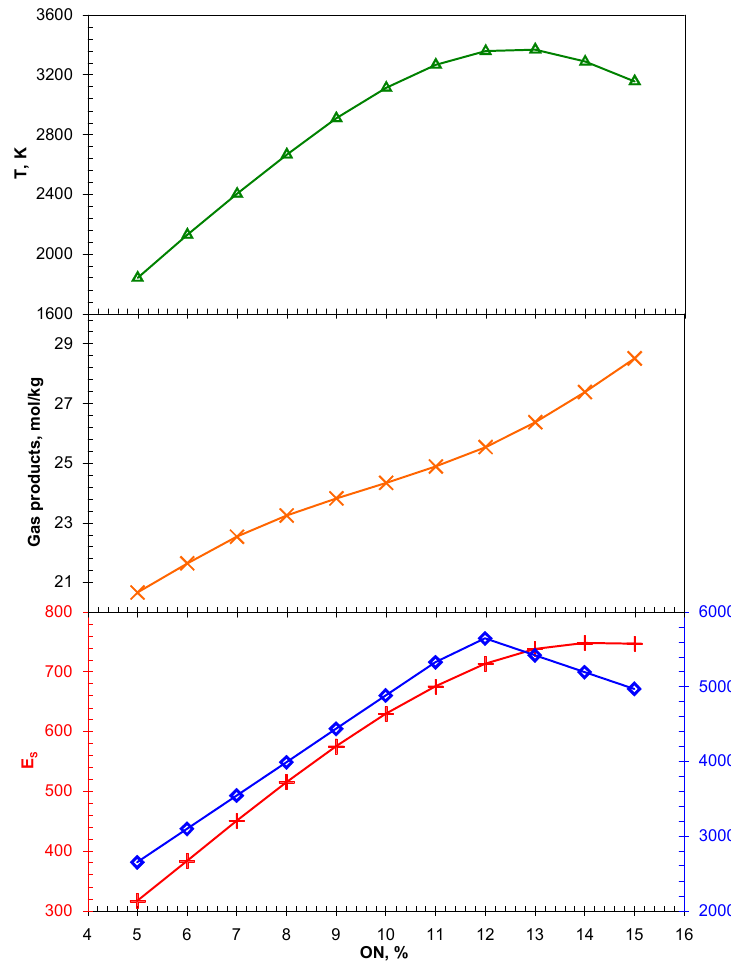
Figure 2. Relationship between thermodynamic parameters of tested mixtures and diesel oil content (ON).